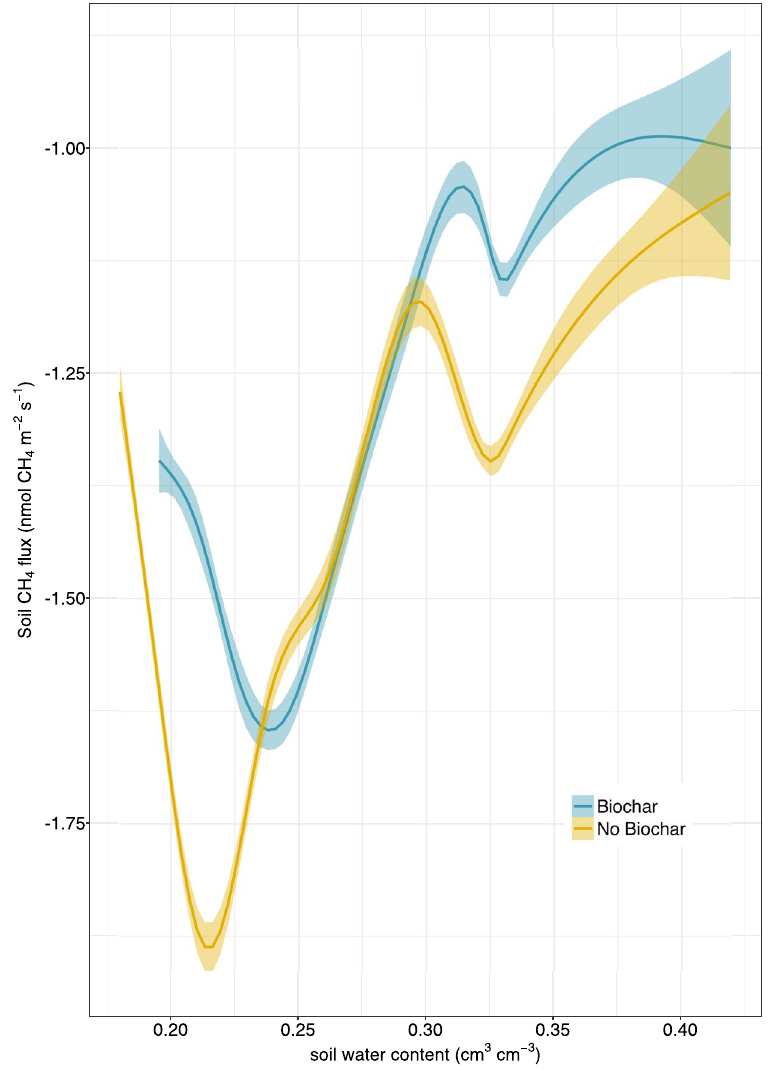
Figure 5. Soil CH 4 fluxes as a function of soil water content for Biochar and No Biochar